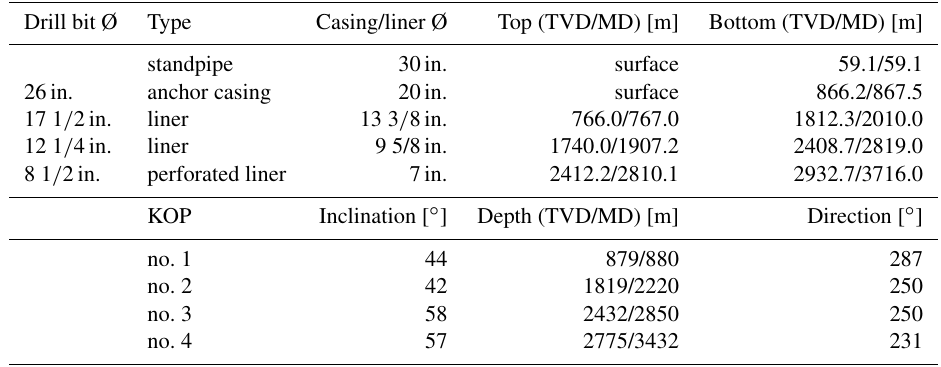
Table 1. Well design at geothermal site Schäftlarnstraße, Munich (see also Fig. 3). Drill bit Ø Type Casing/liner Ø Top (TVD/MD) [m] Bottom (TVD/MD) [m] standpipe 30in. surface 59.1/59.1 26in. anchor casing 20in. surface 866.2/867.5 17 1 / 2in. liner 13 3 / 8in. 766.0/767.0 1812.3/2010.0 12 1 / 4in. liner 9 5/8in. 1740.0/1907.2 2408.7/2819.0 8 1 / 2in. perforated liner 7in. 2412.2/2810.1 KOP Inclination [ ◦ ] Depth (TVD/MD) [m] Direction [ ◦ ] no. 1 44 879/880 287 no. 2 42 1819/2220 250 no. 3 58 2432/2850 250 no. 4 57 2775/3432